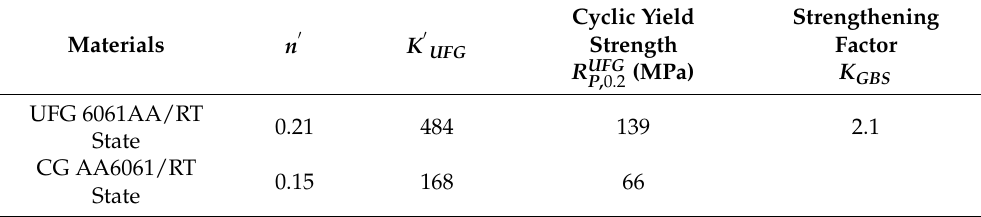
Figure 8. Stress amplitude versus plastic strain amplitude curves of UFG 6061AA. Table 3. Characteristic parameters of UFG 6061AA and CG